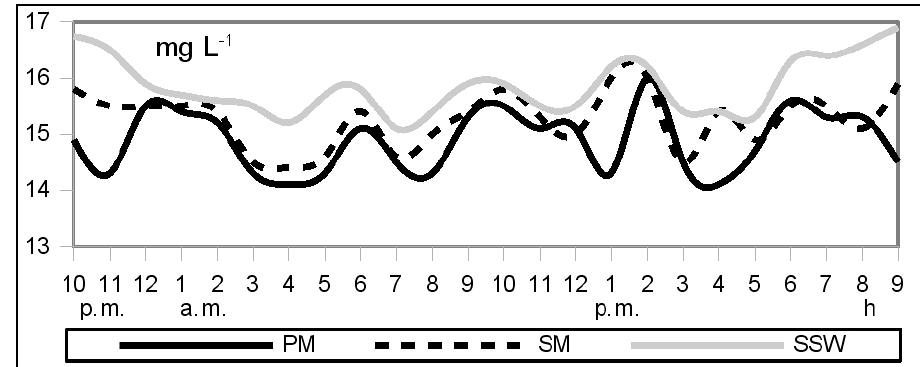
L -1 ) in surface microlayers and subsurface water of Lake Dołgie Wielkie. 2